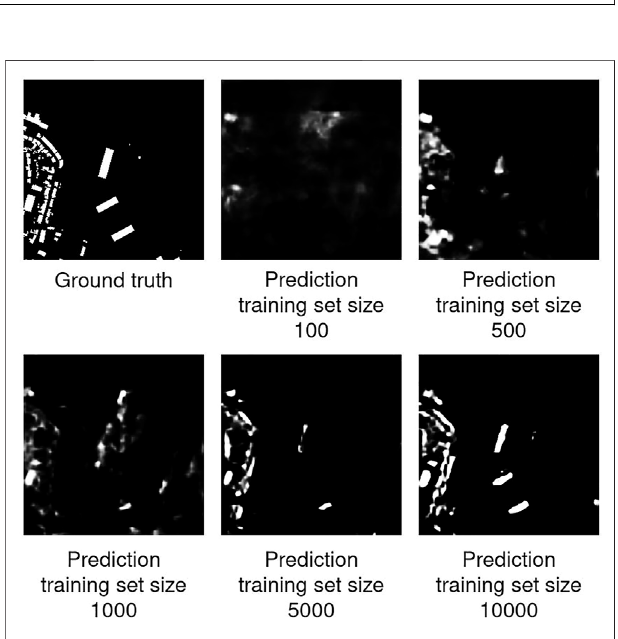
FIGURE 3 | Predictions and ground truth for one image in the validation set. Predictions were made by models trained on clean training data.